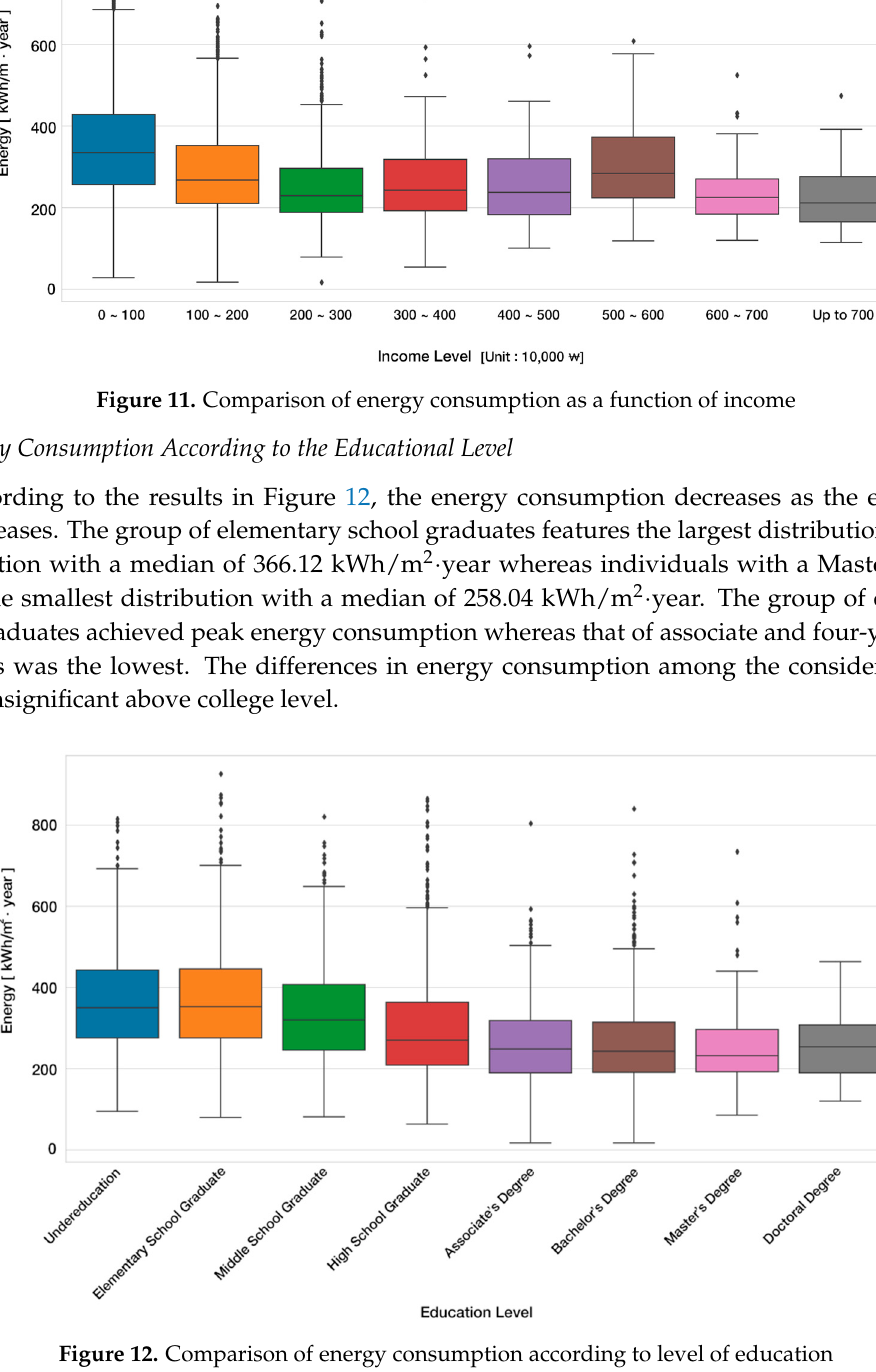
Figure 10. Comparison of energy consumption according to occupational status